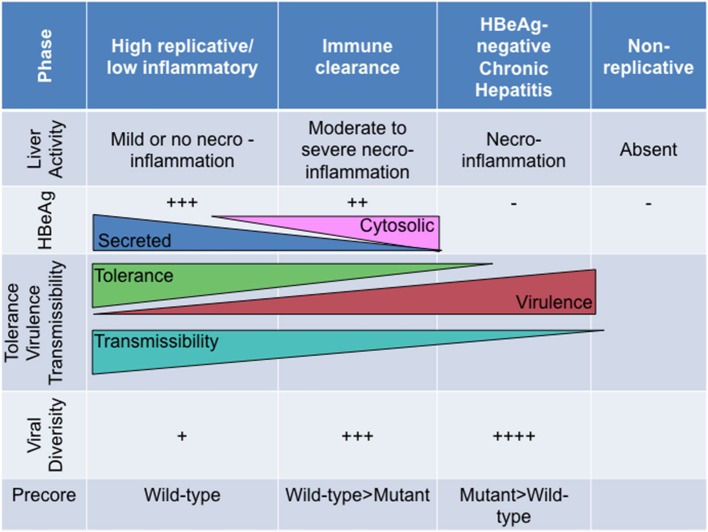
The relationship of HBeAg expression and precore region diversity to the natural history of HBV infection and its effect on tolerance, virulence and transmissibility of HBV.